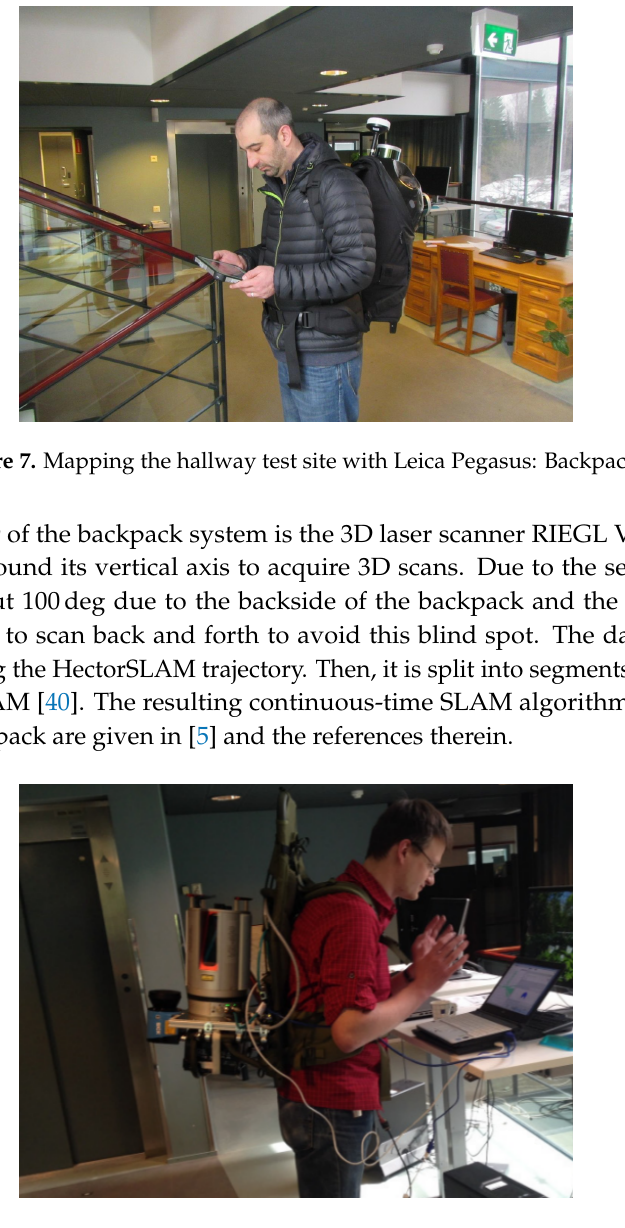
Figure 8. The Würzburg backpack consisting of a SICK LMS100 profiler, a low-end IMU and spinning RIEGL